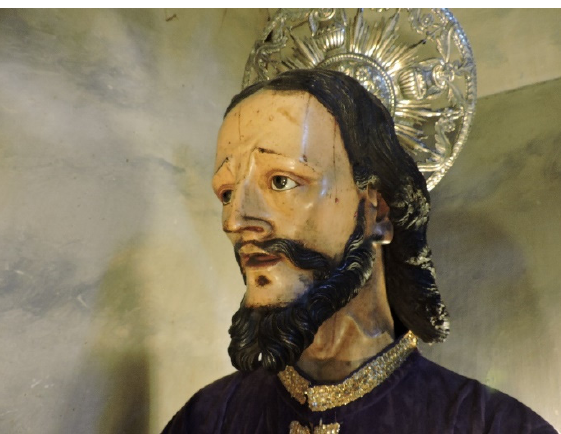
Figure 7. Pedro da Cunha. Agony in the Garden, in the Church of the Third Order of Mount Carmel in Itu. Polychrome wood sculpture (126 × 62 × 52cm), eighteenth century. Photo by Lia Brusadin, 26 December 2016.